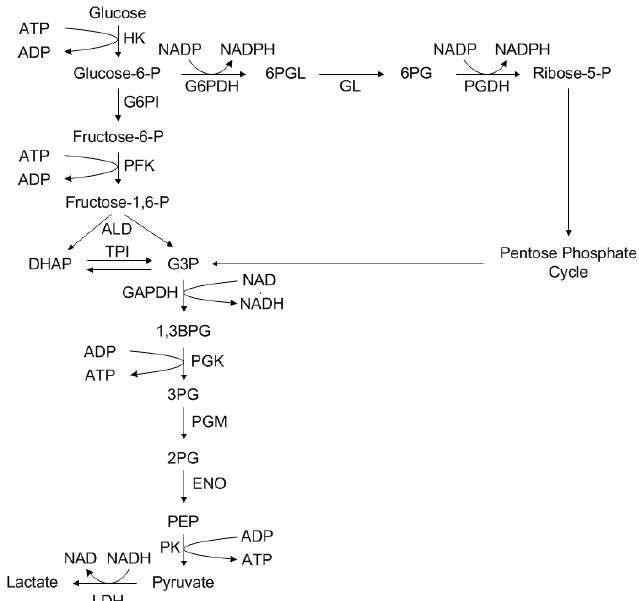
Figure 3. Production of lactate and pyruvate in glycolysis. HK, Hexokinase; G6PI, Glucose ‐ 6 ‐ phosphate isomerase; PFK, Phosphofructokinase; ALD, Aldolase; TPI, Triosephosphate isomerase; GAPDH, Glyceraldehyde ‐ 3 ‐ phosphate dehydrogenase; PGK, Phosphoglycerate kinase; PGM, Phosphoglycerate mutase; ENO, Enolase; PK, Pyruvate kinase; LDH, Lactate dehydrogenase; G6PDH, Glucose ‐ 6 ‐ phosphate dehydrogenase; GL, 6 ‐ Phosphogluconolactonase; PGDH, Phosphogluconate dehydrogenase; DHAP, Dihydroxyacetone phosphate; G3P, Glyceraldehyde 3 ‐ phosphate; 1,3BPG, 1,3 ‐ Bisphosphoglycerate; 3PG, 3 ‐ Phosphoglycerate; 2PG, 2 ‐ Phosphoglycerate; PEP, Phosphoenolpyruvate; 6PGL, 6 ‐ Phosphogluconolactone; 6PG, 6 ‐